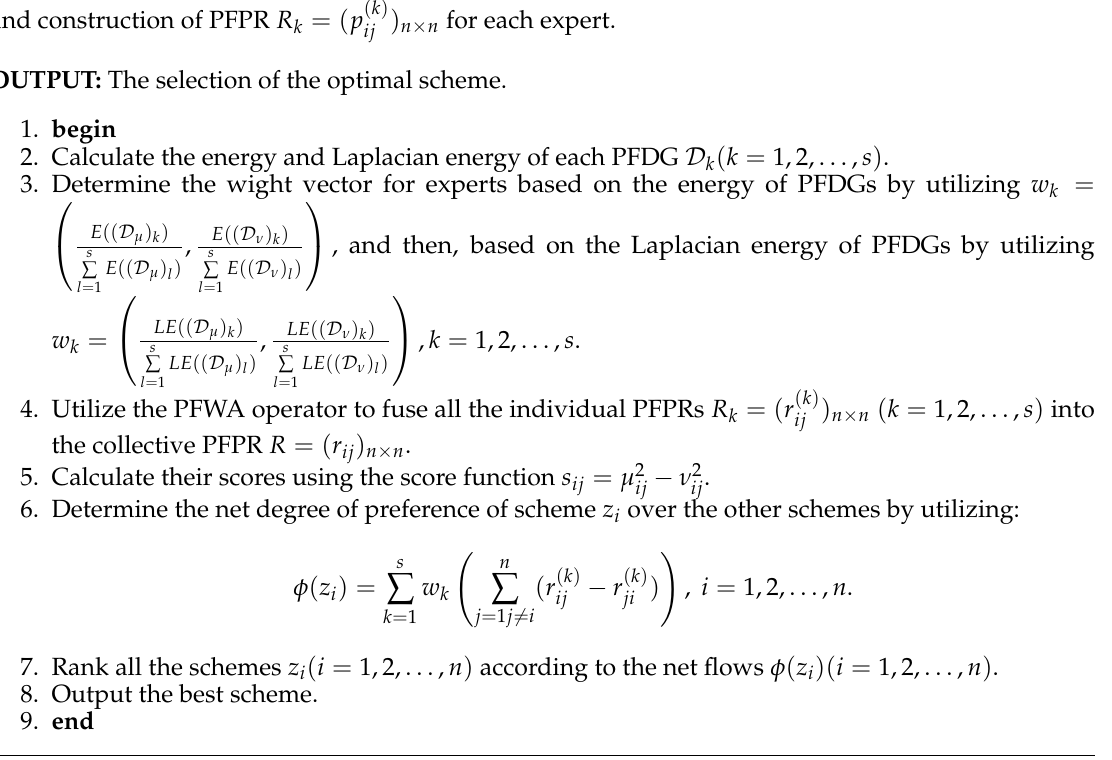
Algorithm 2 The algorithm for the selection of the most important scheme of reservoir